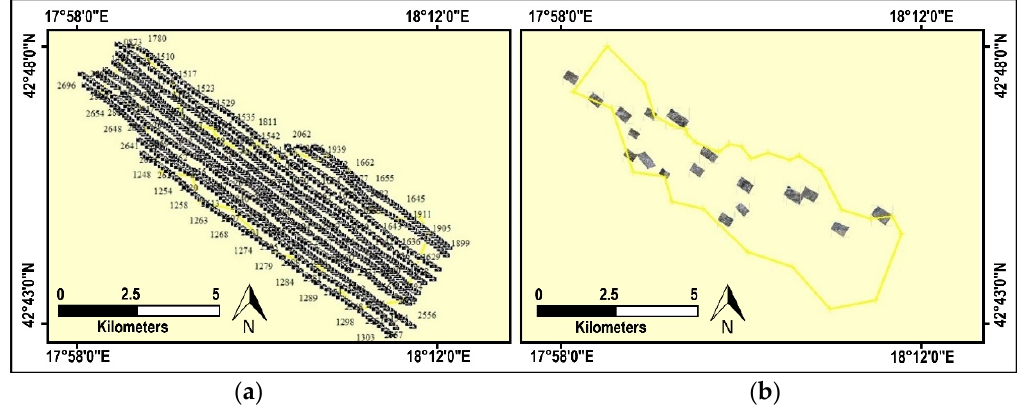
Figure 6. Examples of depictions of ( a ) geotagged images and ( b ) selected and georeferenced images, after triage, which contain indicators of mine presence in one suspected hazardous area (yellow polygon).